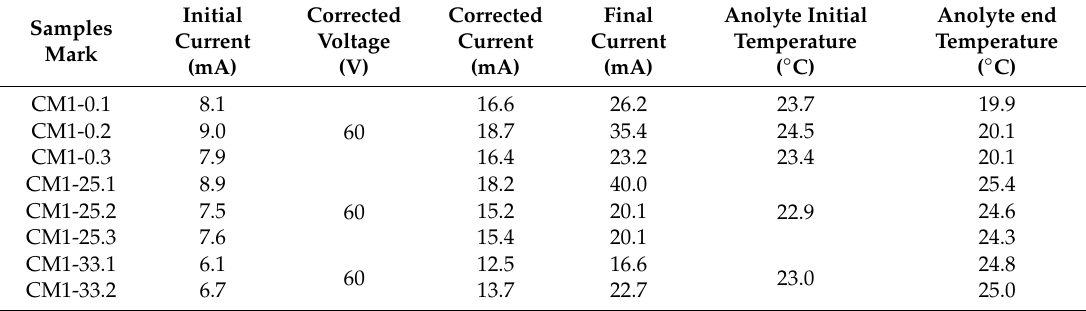
Table 5. Measurement parameters for the testing of the chloride ion migration coe ffi